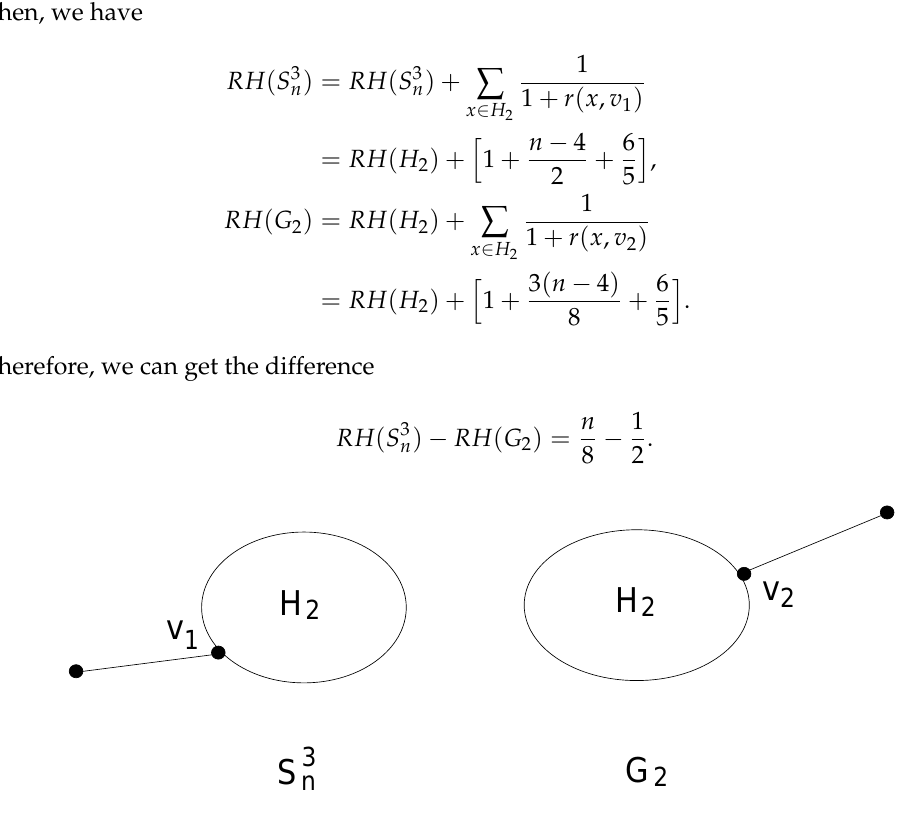
Figure 5. The graphs S 3 n and G 2